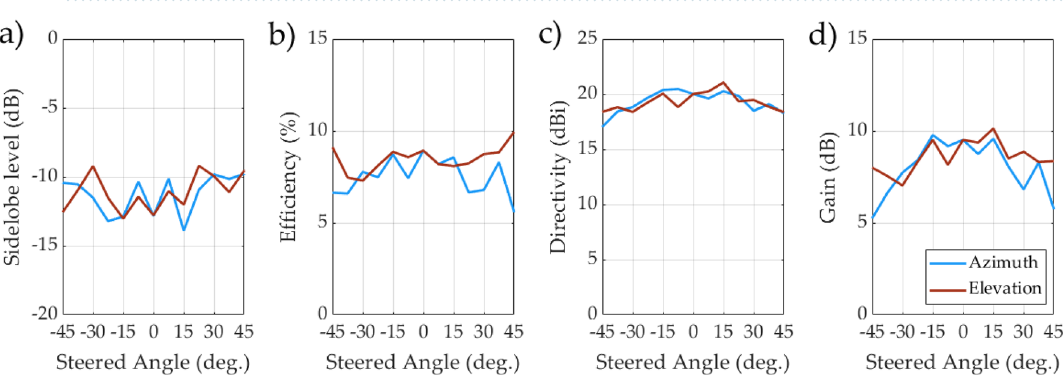
Figure 8. Frequency coverage of the Nyquist metasurface antenna, determined by broadside beam formation. For each measurement, a new tuning state has been applied. Plots show radiation pattern (dB).